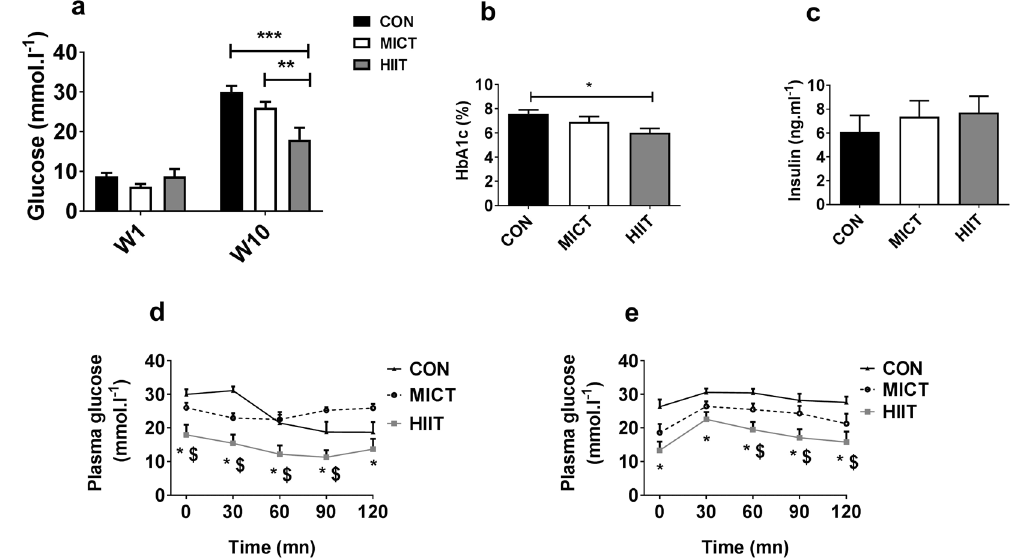
Figure 1. Effects of 10 weeks of MICT or HIIT on fasting blood glucose ( a ), glycosylated haemoglobin ( b ), fasting serum insulin ( c ) and blood glucose response to ITT ( d , f ) and OSTT ( e , g ). Data are expressed as means ± SEM. * p < 0.05; ** p < 0.01; * Significantly different from CON; $ Significantly different from MICT.